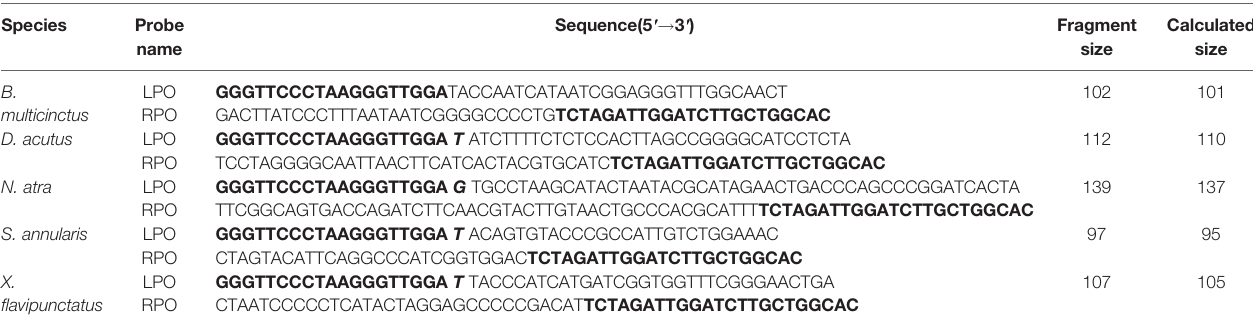
TABLE 1 | The information of probes in this MLPA